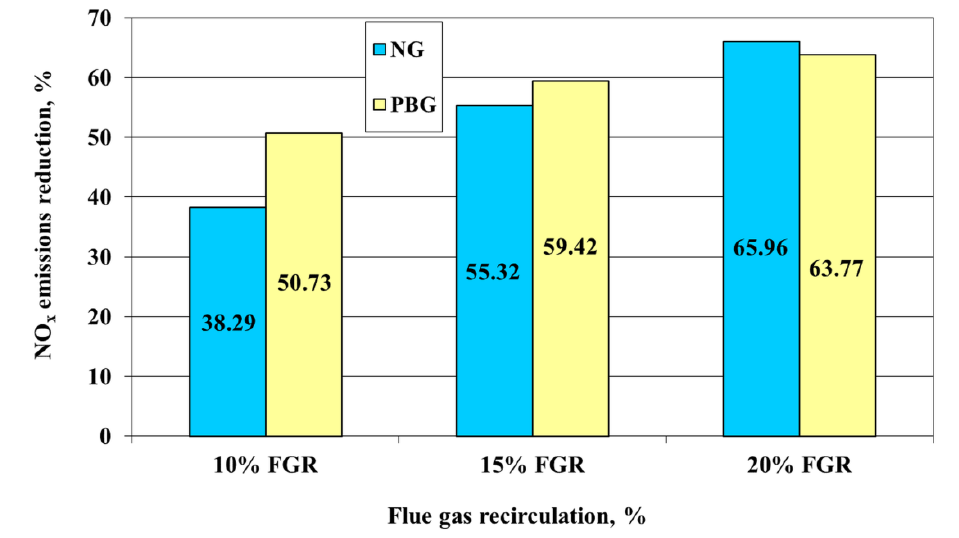
Figure 11. Nitrogen oxide emissions reduction after the application of flue-gas recirculation: comparison of natural gas (NG) and propane–butane gas (PBG) combustion at various flue-gas recirculation rates. For both fuels, burner power input was 16 kW and air excess coefficient m = 1.1.